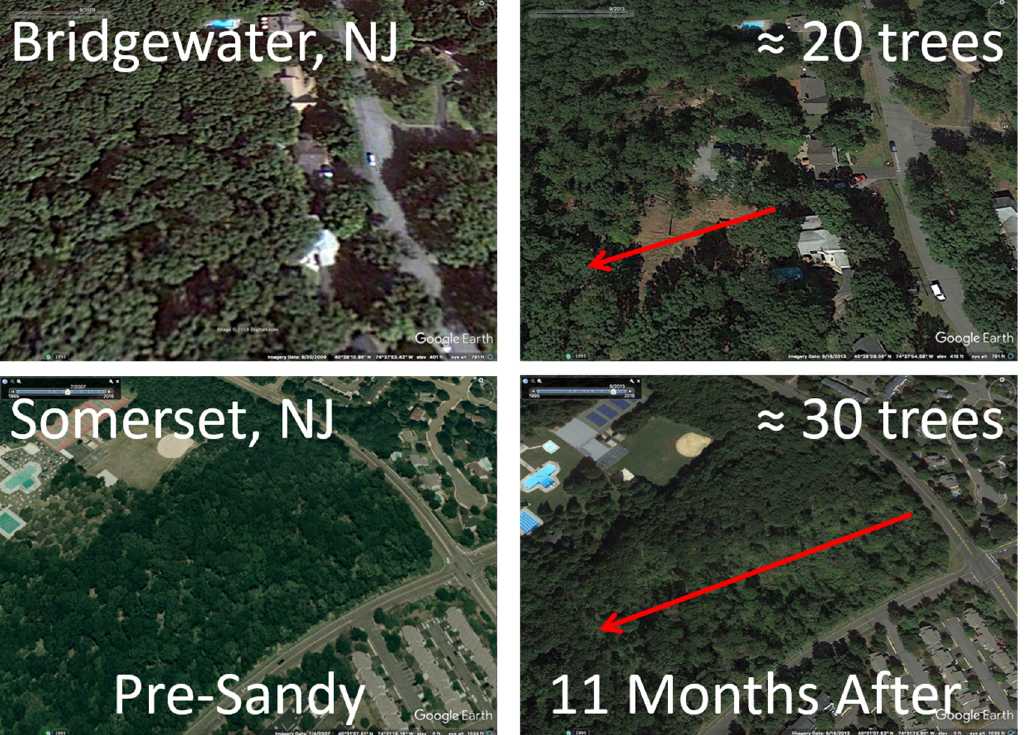
Figure 1. Landsat images comparing the treefall pattern after Sandy’s landfall with those before landfall at two locations: Bridgewater and Somerset, NJ. Arrow length and direction indicate treefall patch extent and treefall direction, respectively. Map data ©2013 Google.